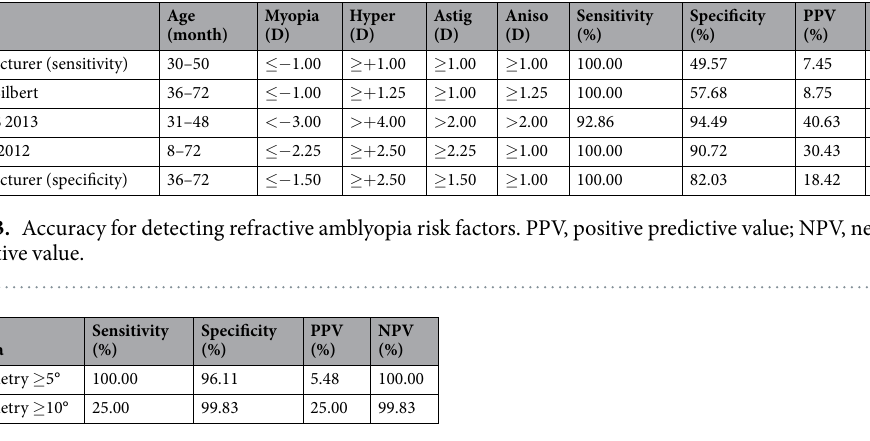
Table 4. Accuracy for detecting strabismic amblyopia risk factors. PPV, positive predictive value; NPV, negativepredictive value.